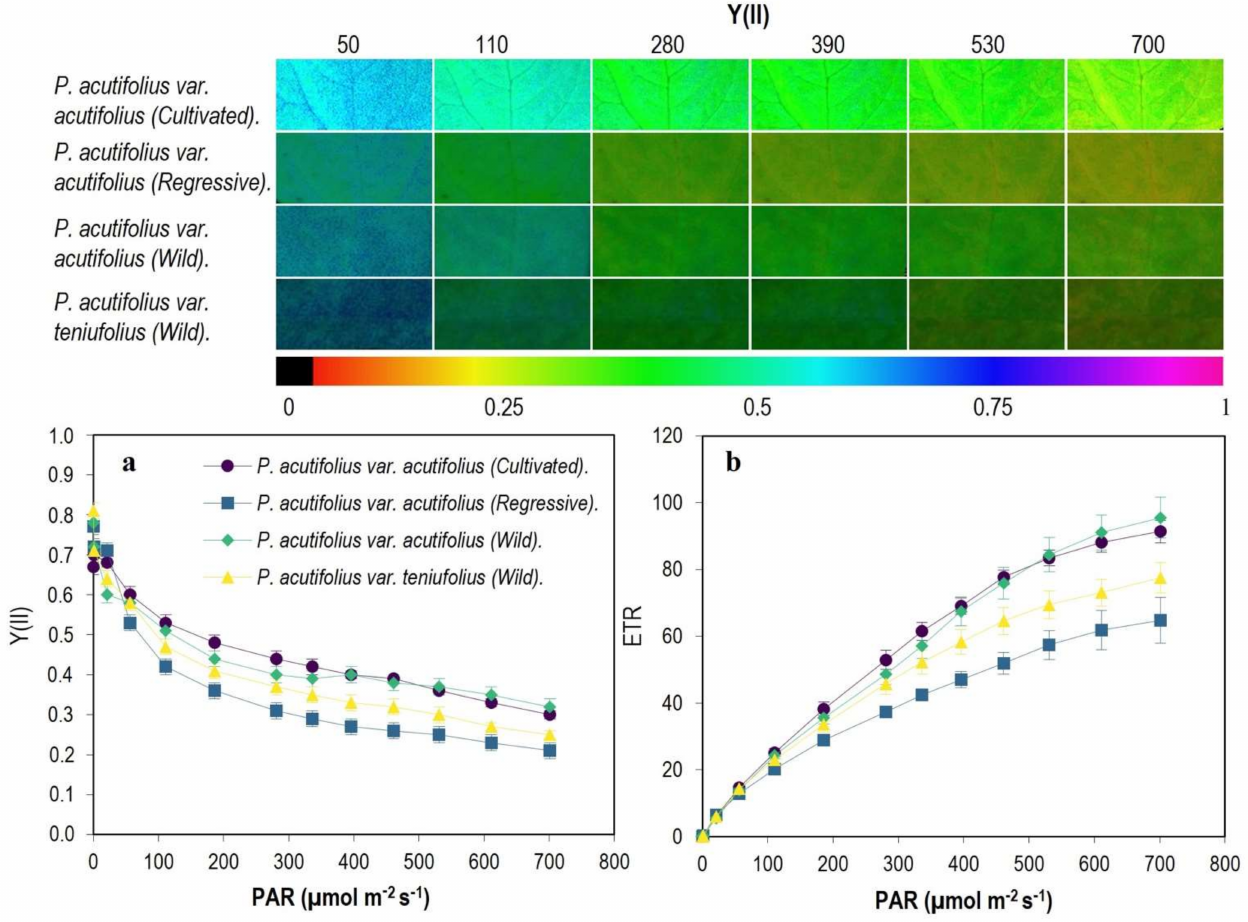
Figure 5. Behavior of the photosynthetic machinery as a function of PAR among the tepary bean genetic resource. ( a ) Photochemical yield (Y(II)), ( b ) electron transport rate (ETR). In the upper panel, gradient in color change from violet to red means higher to lower value for each variable. Means and error bars correspond to 20 AOI (area of interest) from four leaves of each accession, i.e., 5 AOI were tested on each